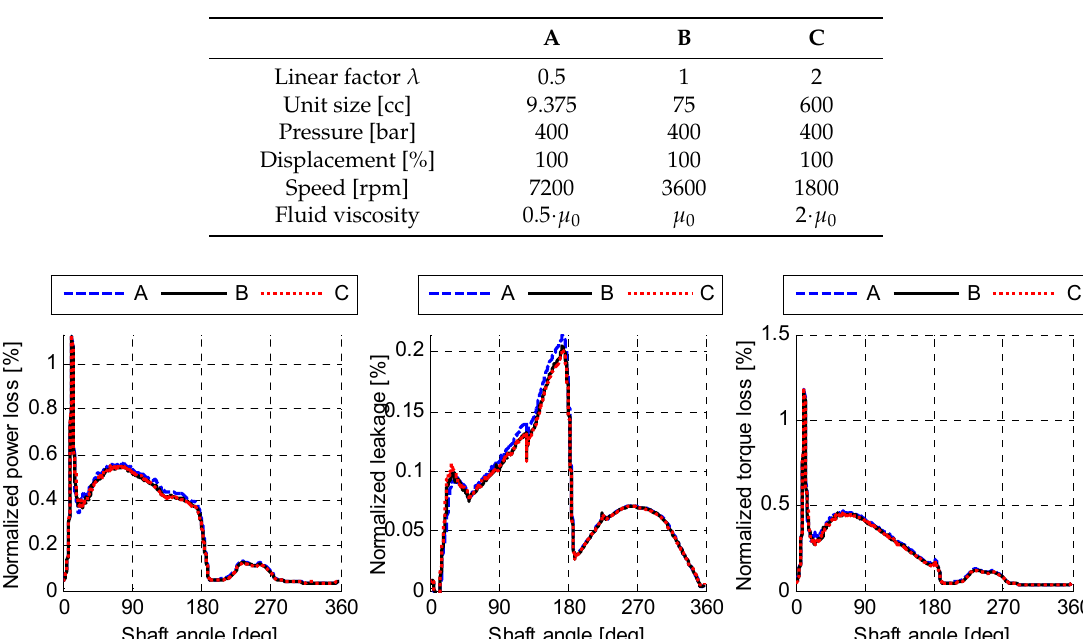
Table 2. Summary of operating conditions with scaled fluid viscosity.